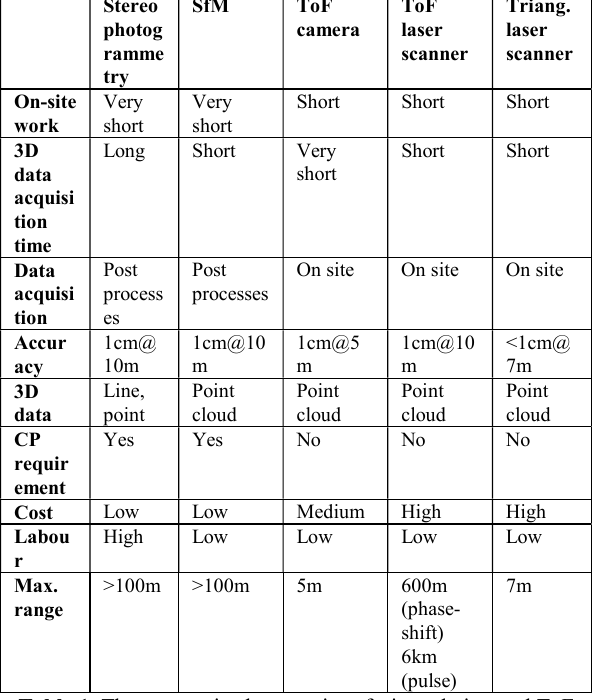
Table 1. The summarized properties of triangulation and ToF measurement techniques in cultural heritage